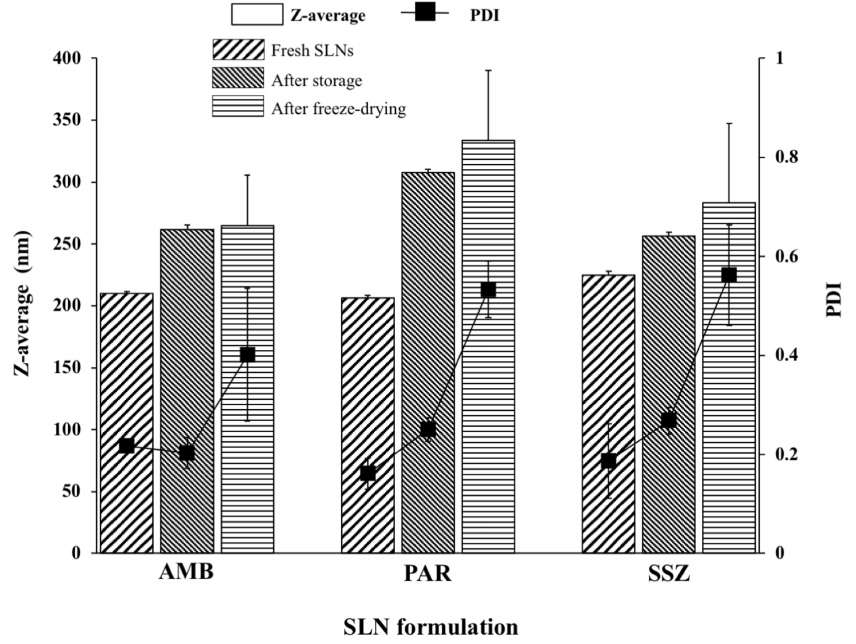
Figure 4. z-Average diameters and PDIs (polydispersity indexes) of freshly prepared, stored (for 24 months), and lyophilized AMB-SLNs, PAR-SLNs, and SSZ-SLNs ( n =